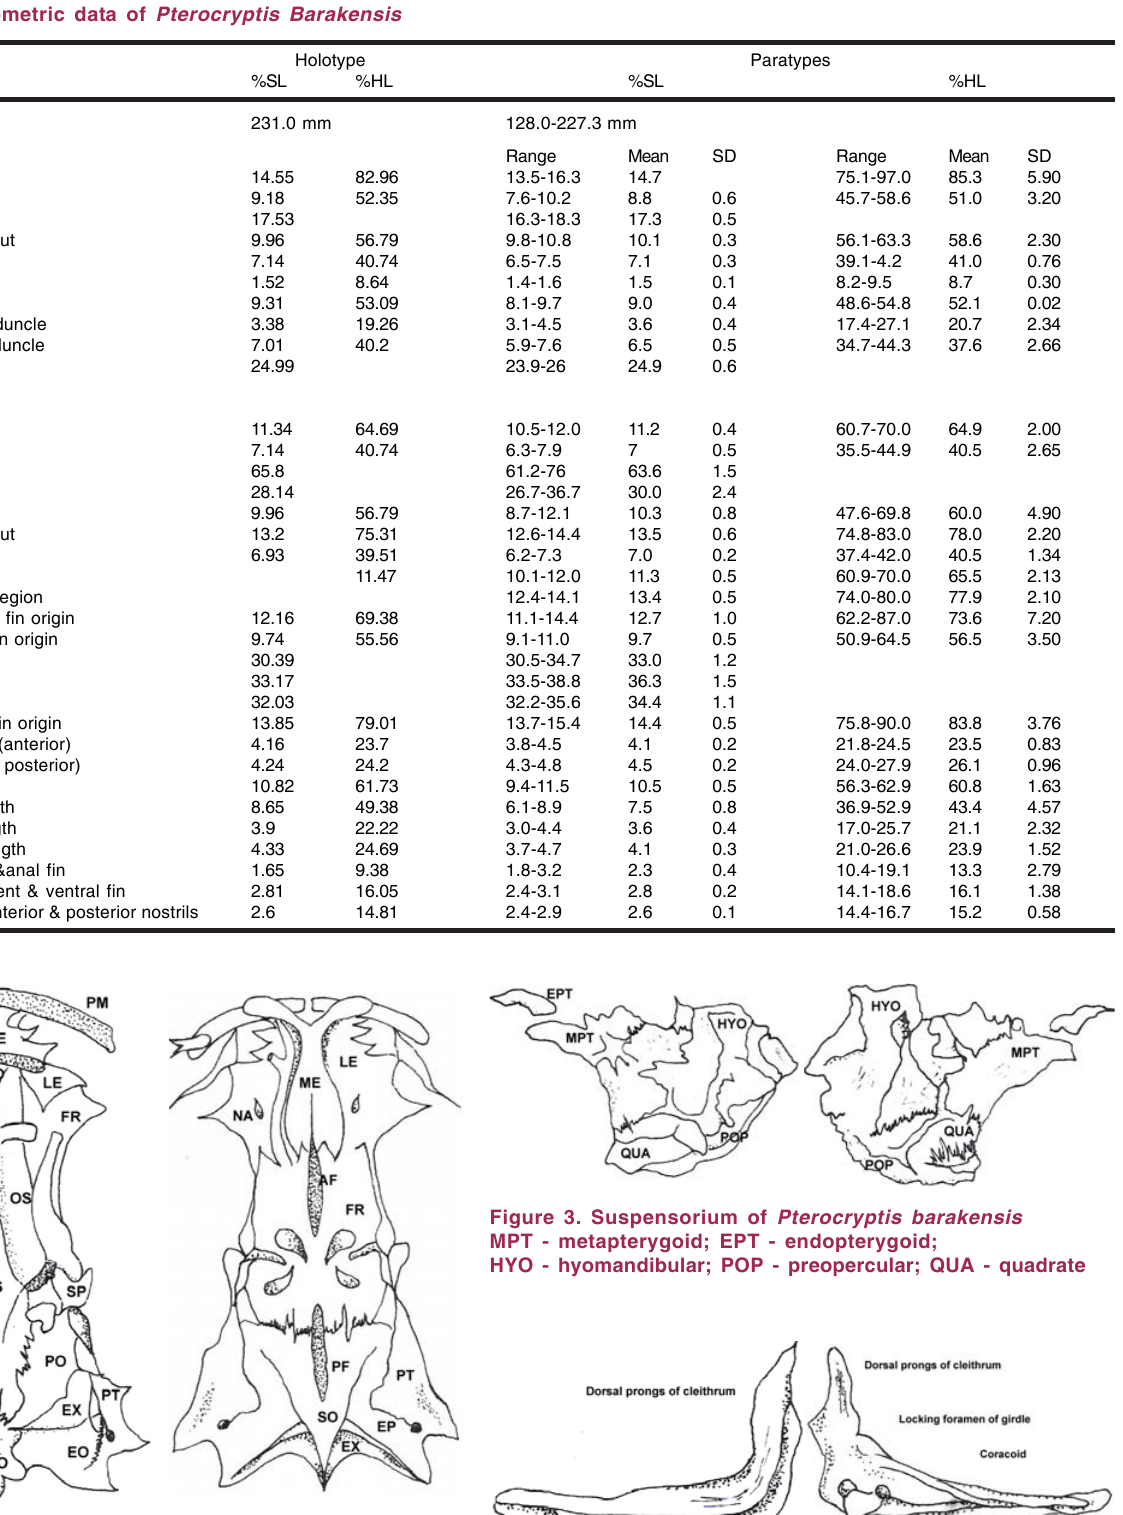
Figure 2. Skull of Pterocryptis barakensis a - dorsal view; b - ventral view; LE - lateral ethmoid; ME - mesethmoid; NA - nasal; AF - anterior fontanel; FR - frontal; PF - posterior fontanel; SO - supraoccipital; PT - pterotic; EP - epioccipital; EX - exoccipital; PM - premaxilla; VO - vomer; OS - orbitosphenoid; PS - parasphenoid; PO - pro-otic; BO - basioccipital.